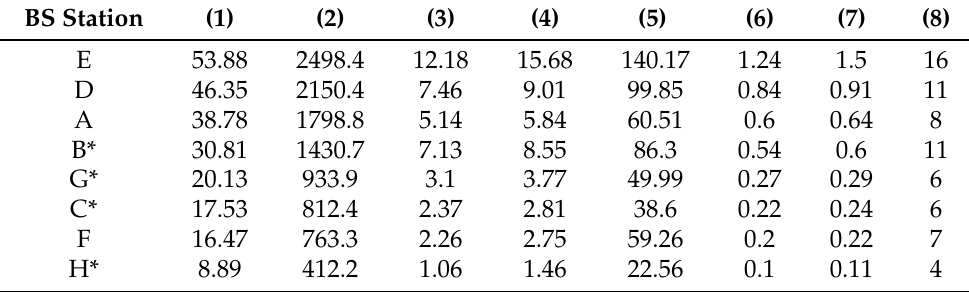
Table 3. Assessments (serial numbers are referred to indicators) of BS stations.